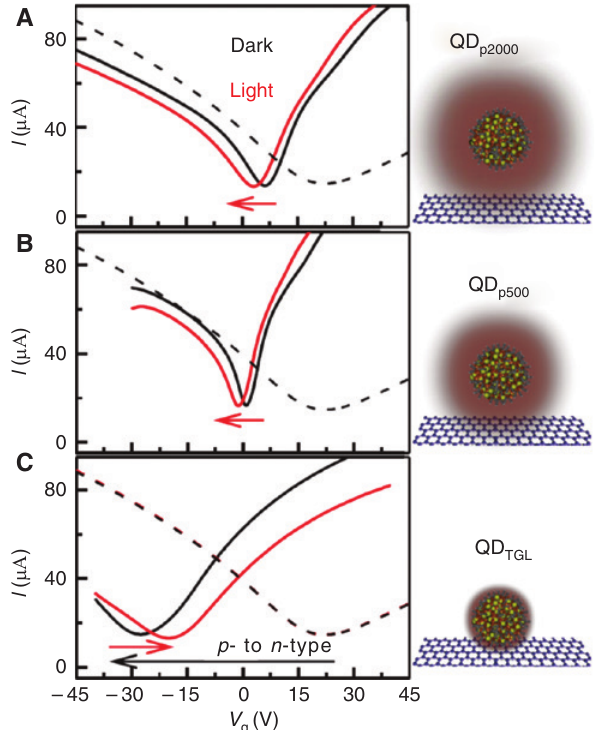
Figure 8: The gate voltage shift due to QD deposition (black solid lines) and the light induced shift (red lines) in graphene transistors with PbS QD nanomaterials with different ligands